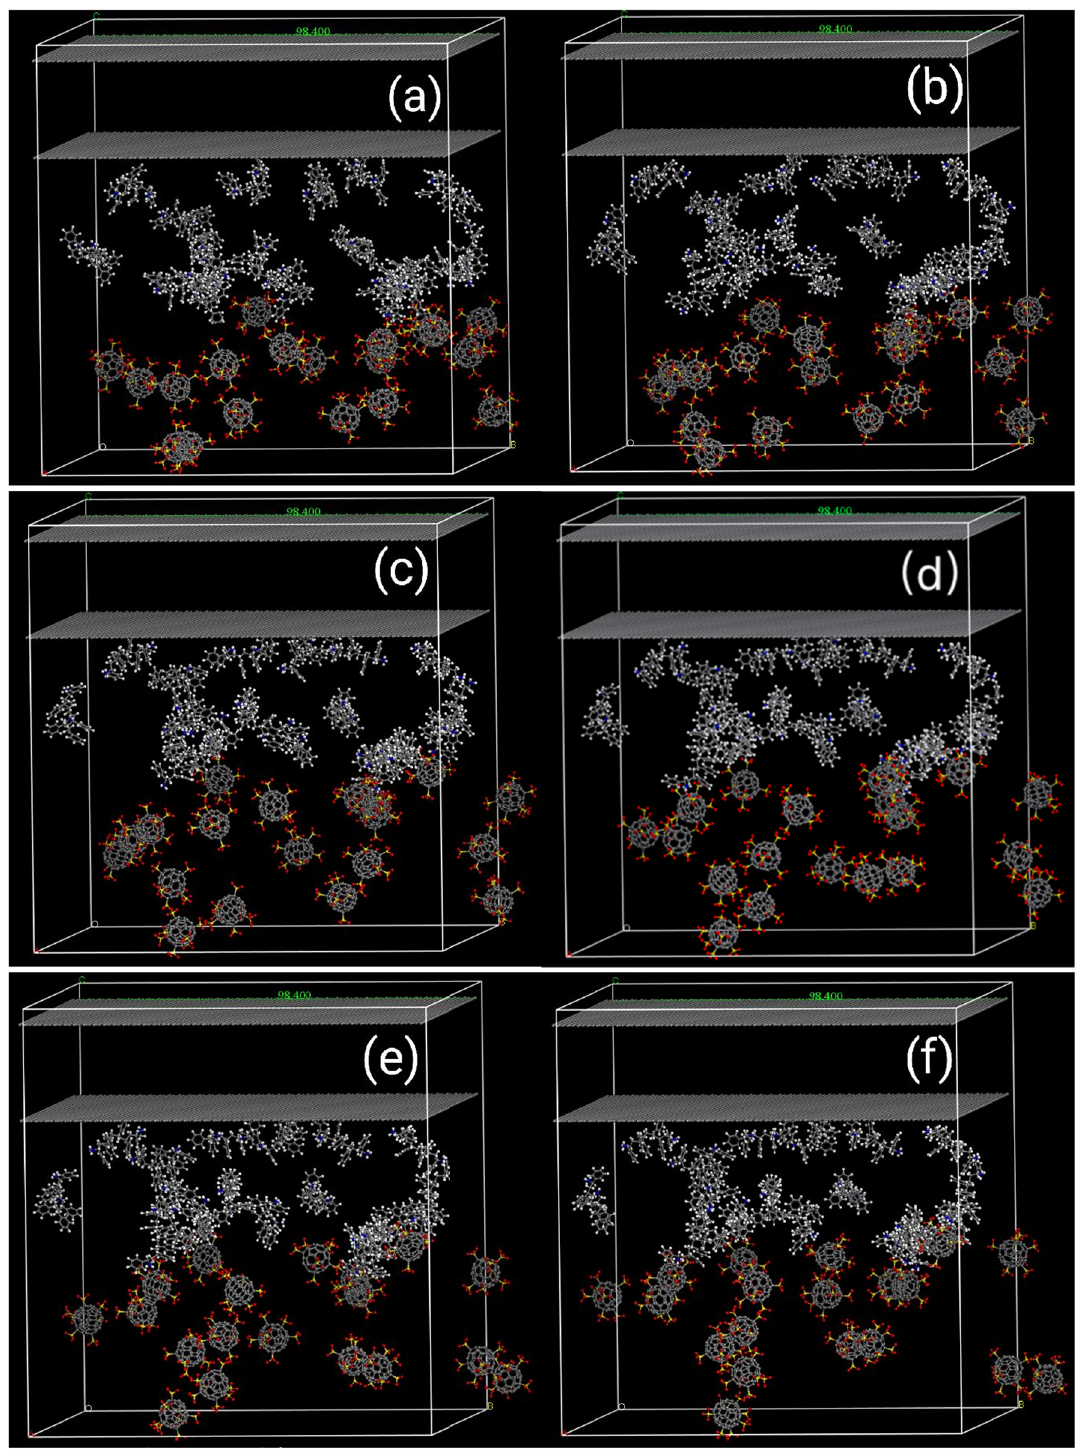
Figure 7: MD simulation of H 2 N – PS – NH 2 compounding with CDs – SO 3 H; ( a ) 0 ps; ( b ) 3 ps; ( c ) 10 ps; ( d ) 25 ps; ( e ) 50 ps; ( f ) 100